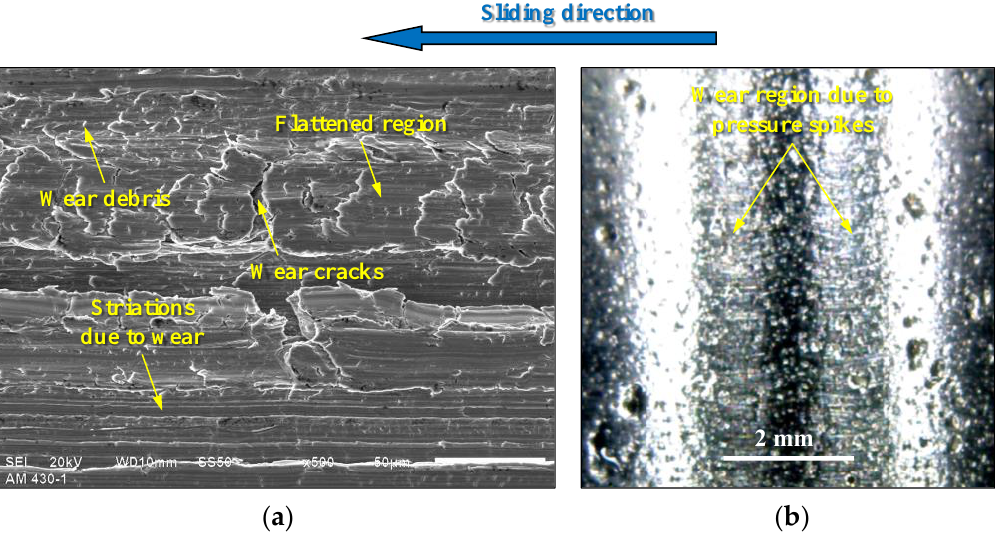
Figure 14. Image of tribological pair surface: ( a ) specimen and ( b ) counter samples (bending pin).